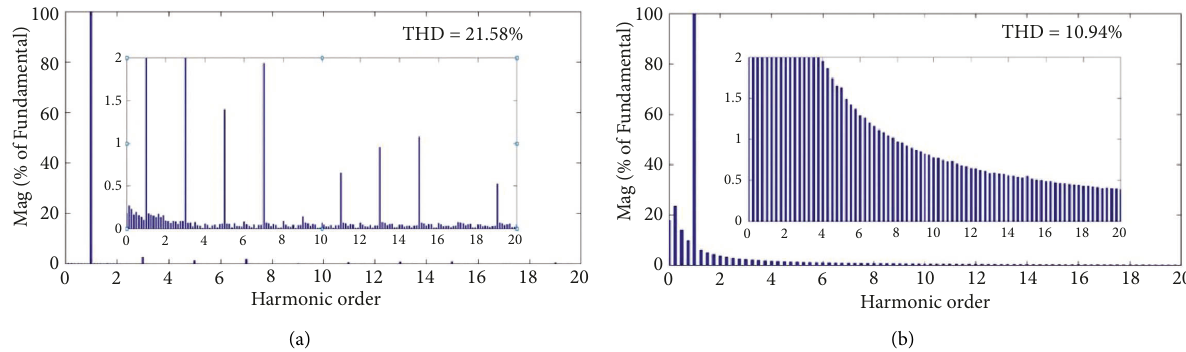
Figure 15: THD analysis (MI-0.7). (a) Voltage THD, (b) current